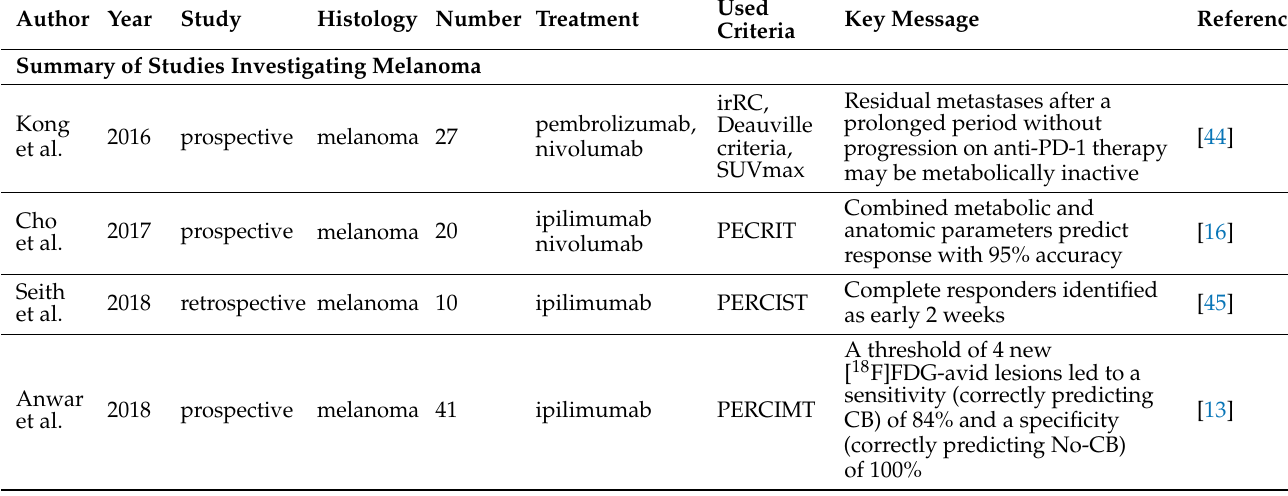
Table 2. Summary of major studies investigating PET/CT for immunotherapy response assessment and outcome